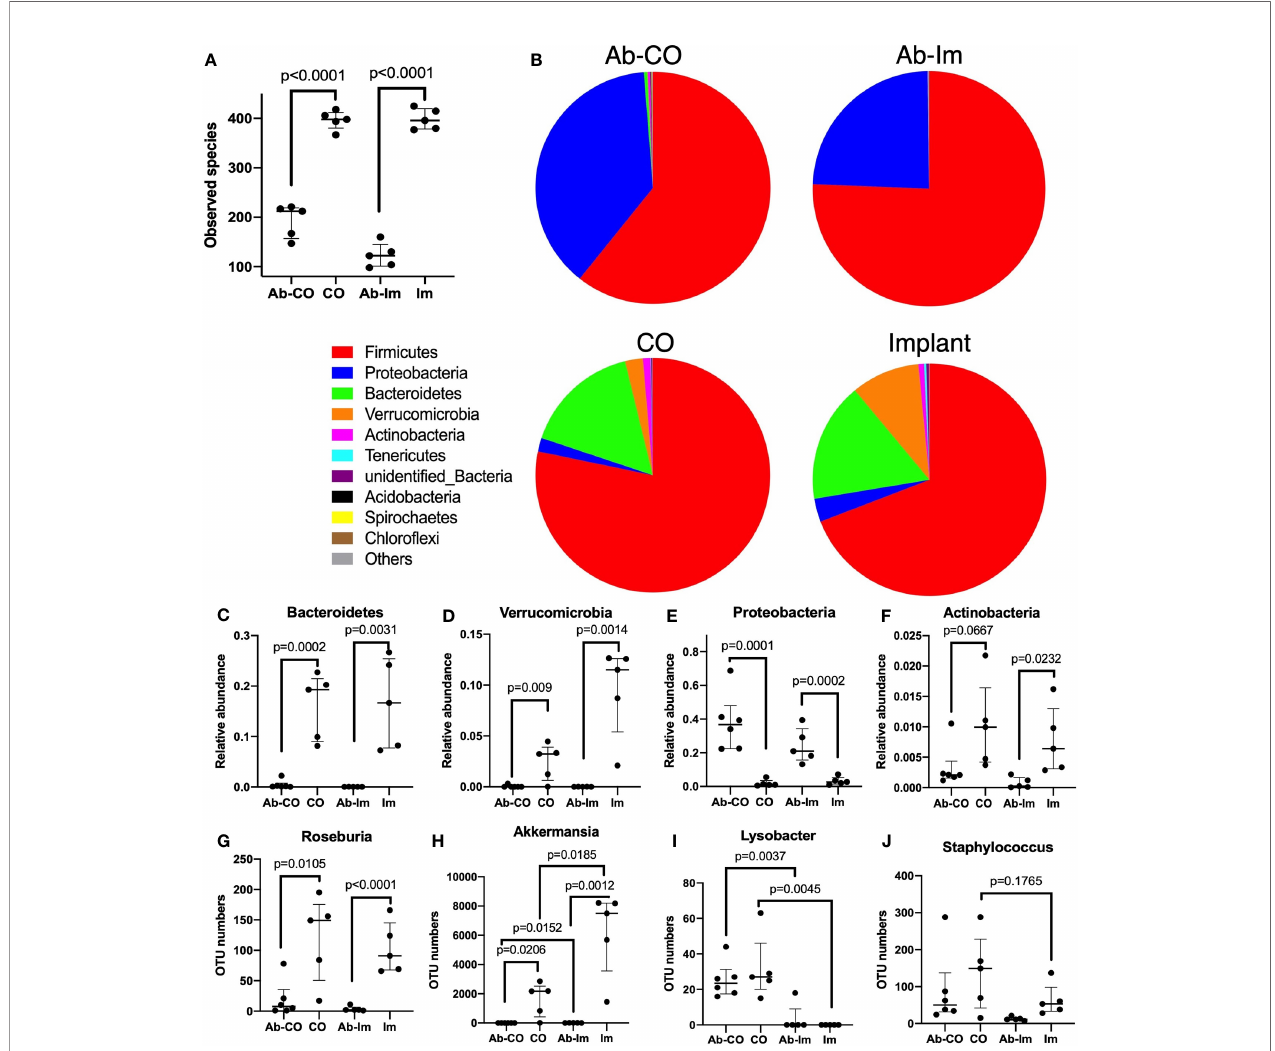
FIGURE 5 | A high-dose broad-spectrum antibiotic cocktail signi fi cantly disrupted the host gut microbiota. After 5 weeks of antibiotic treatment, intestinal contents specimens were harvested and analyzed via 16S rRNA sequencing from mice in untreated, antibiotic-treated (Ab), chronic osteomyelitis (CO), antibiotic-treated CO (Ab-CO), implant (Im), and antibiotic-treated implant (Ab-Im) groups ( n =5 – 6 mice/group). (A) Observed numbers of species for all groups; (B) The relative composition of bacterial phyla shown in all groups. (C – F) Relative abundance of Bacteroidetes , Verrucomicrobia , Proteobacteria , and Actinobacteria phylum. (G – J) OTU number of Roseburia, Akkermansia, Lysobacter , and Staphylococcus genus. Data for observed species, OTU number and relative abundance are shown as median and interquartile range. All data were analyzed by unpaired t -test between Ab-CO and CO, or between Ab-Im and Im